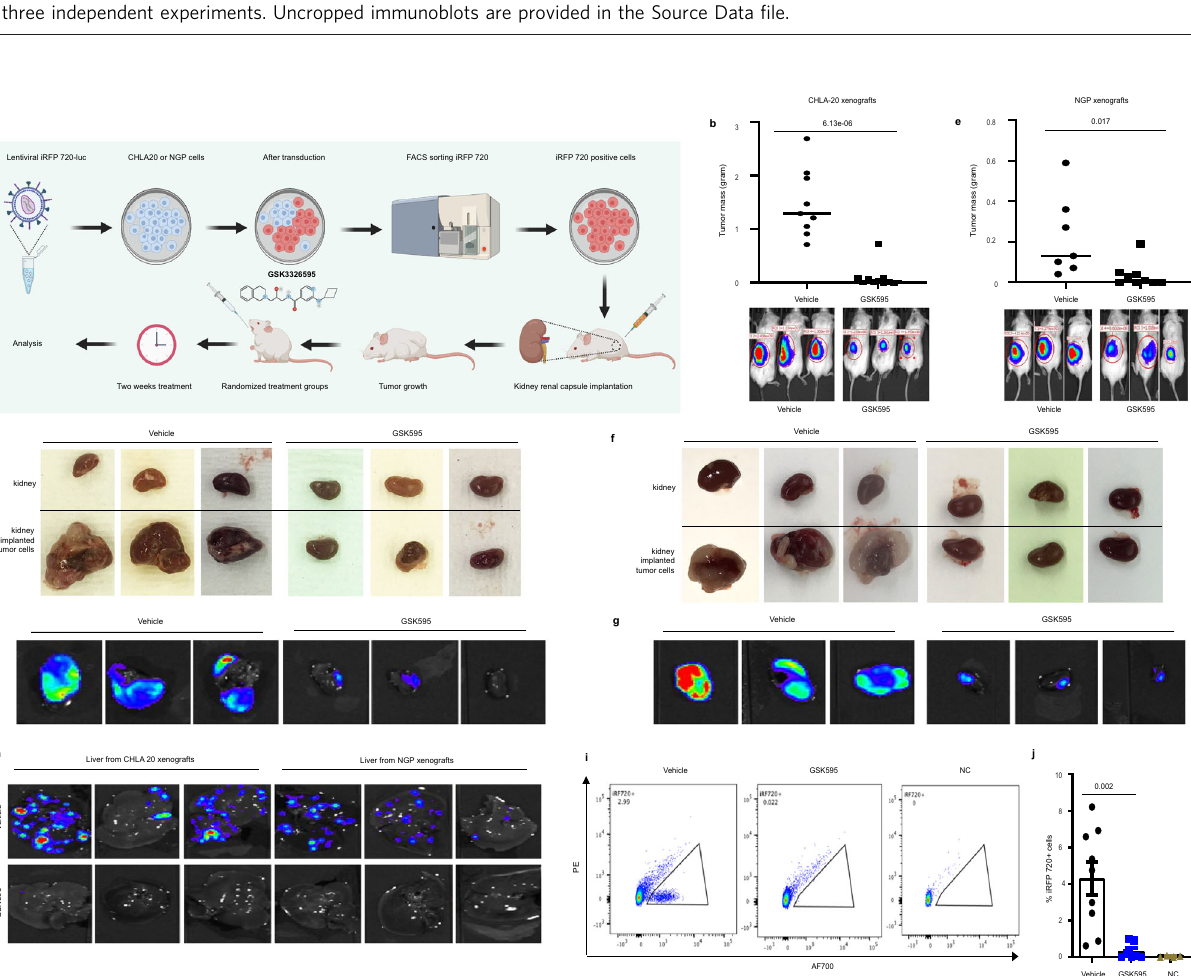
Fig. 2 Inhibiting PRMT5 methyltransferase activity attenuates primary tumor growth and metastasis. a Schematic diagram of PRMT5 inhibitor GSK3326595 (GSK595) in vivo study in the kidney renal capsule implantation xenograft model. b Tumor mass of CHLA20 iRFP720-Luc xenograft tumors from mice treated with vehicle ( n = 9) or GSK595 ( n = 10) (top) and representative in vivo bioluminescent images and quanti fi cation of tumor (bottom). Tumor mass was calculated by subtracting the weight of the normal kidney from the weight of the kidney that was implanted with tumor cells. Representative ex vivo images of the tumor by light microscope ( c ) or bioluminescence ( d ). e Tumor mass of NGP iRFP720-Luc xenograft tumors from mice treated with vehicle ( n = 7) or GSK595 ( n = 9) (top) and representative in vivo bioluminescent images and quanti fi cation of tumor (bottom). Representative ex vivo images of the tumor by light microscope ( f ) or bioluminescence ( g ). h Representative ex vivo bioluminescent images of liver from mice bearing CHLA 20 or NGP xenograft tumors treated with vehicle or GSK595. i Representative charts of FACS analysis of iRFP720 positive human neuroblastoma cells in hepatocytes isolated from the whole liver from CHLA20 xenografted mice, NC negative control. j Quanti fi cation of the percentage of iRFP720 positive tumor cells determined by fl ow cytometry in hepatocytes isolated from the whole liver from CHLA20 xenografted mice. Vehicle, n = 9, GSK595, n = 7, NC, n = 4. p values were indicated by a two-tailed unpaired Student ’ s t -test using Microsoft Excel; error bars represent SD ( b , e , j